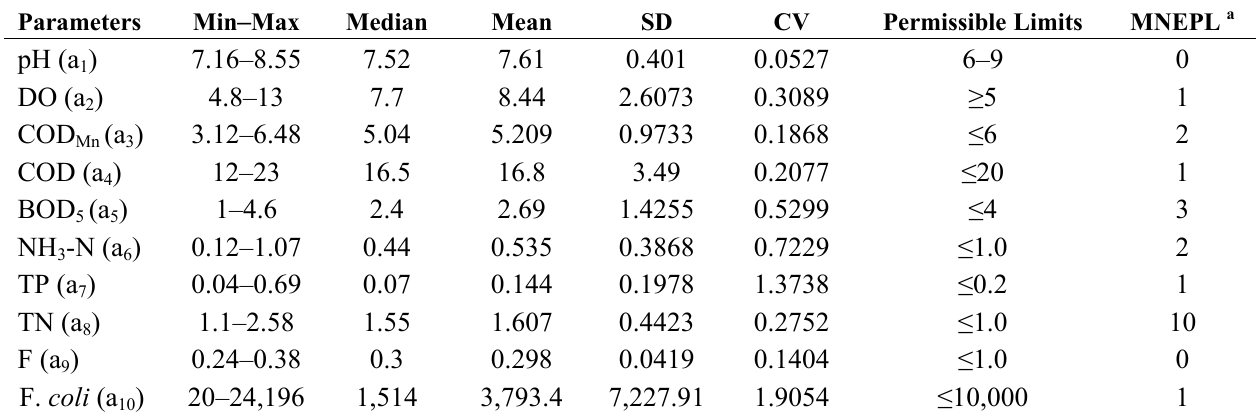
Table 2. Statistical analysis results for various